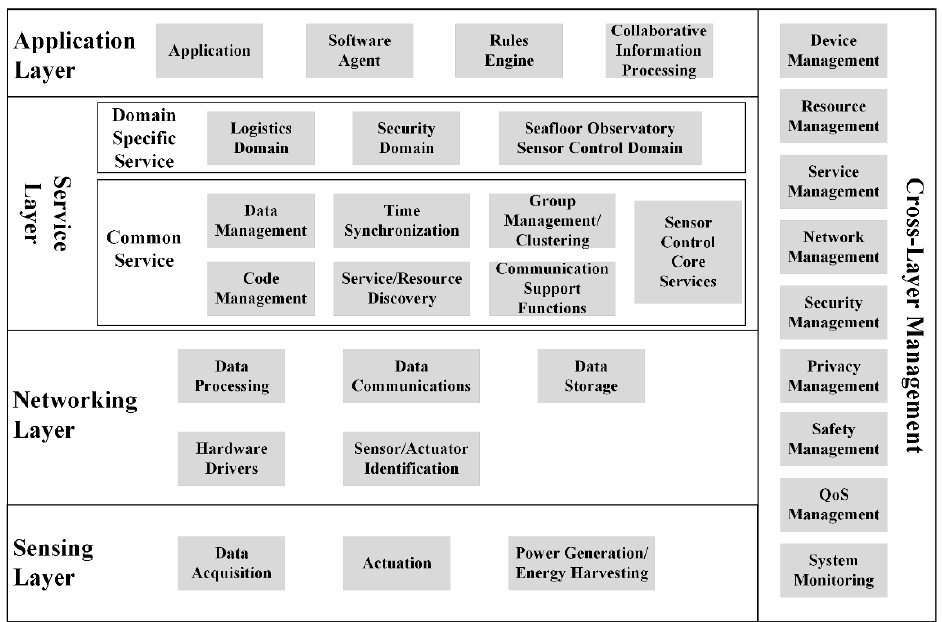
Figure 1. Functional Entities for Controlling Seafloor Observatory Sensor Networks.